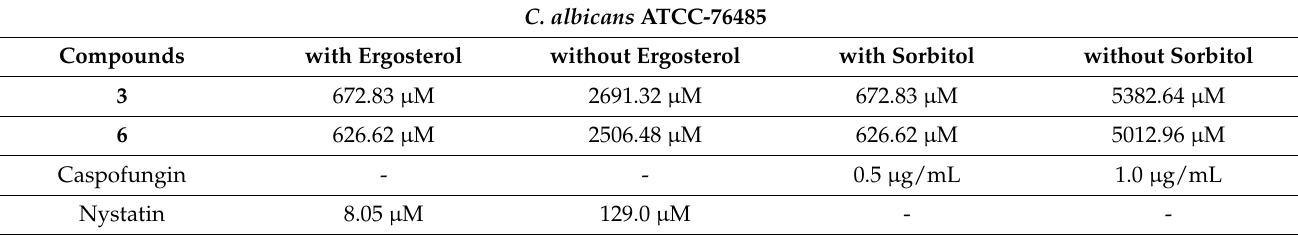
Table 3. Effects of compounds 3 and 6 in the presence or absence of a protective osmotic (sorbitol 0.8 M), as well as in the presence or absence of ergosterol, against the strains of C. albicans .